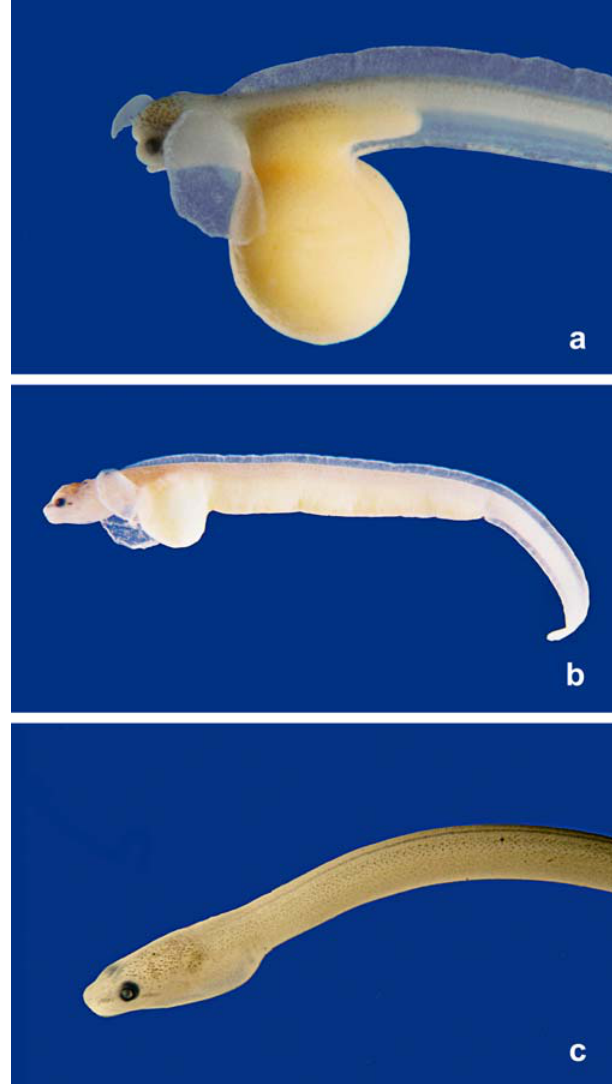
Fig. 6 . Eggs and larval stages of Synbranchus lampreia . (a) anterior portion of larva in Stage D; (b) larva in Stage E, and (c) anterior portion of juvenile in Stage